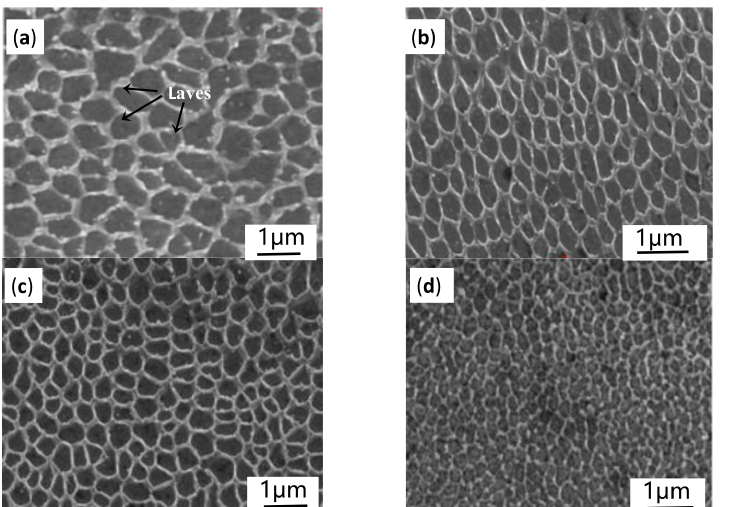
Figure 10. SEM images on the X-Y plane in the melt pool’s central fusion zone under different laser energy density, laser powers and scan speeds: ( a ) 103 J/mm 3 , 90 W, 1000 mm/s; ( b ) 143 J/mm 3 , 100 W, 800 mm/s; ( c ) 171 J/mm 3 , 90 W, 600 mm/s; ( d ) 190 J/mm 3 , 100 W, 600 mm/s. Table 5. The relationship between E and the diameters of the columnar dendrites in the X-Z plane. Input laser energy density (E, J/mm 3 ) 103 143 171 190 Diameter of columnar dendrites in the X-Z plane( µ m) 0.53 0.42 0.31